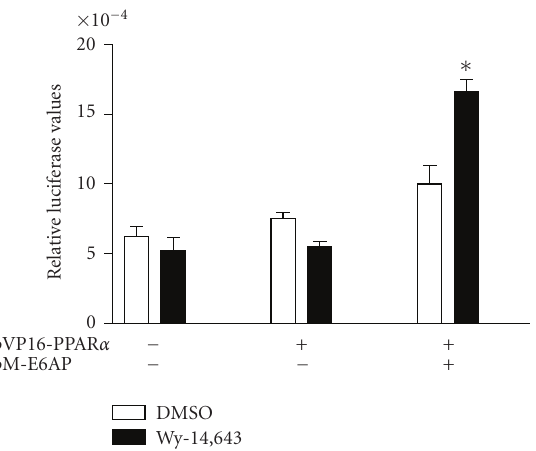
Figure 3: E6-AP interacts with PPAR α . 293T cells were transfected with plasmids expressing pFR-Luciferase, pRLCMV, pVP16-PPAR α , pM-E6-AP. Cells were lysed and luciferase activity was corrected for transfection e ffi ciency and protein. Asterisks indicate a signif- icant di ff erence in Wy-14,643 induction when compared to the corresponding DMSO group. ( ∗ P < . 05 with statistical analysis using ANOVA). The graph is representative of 2 independent experiments.